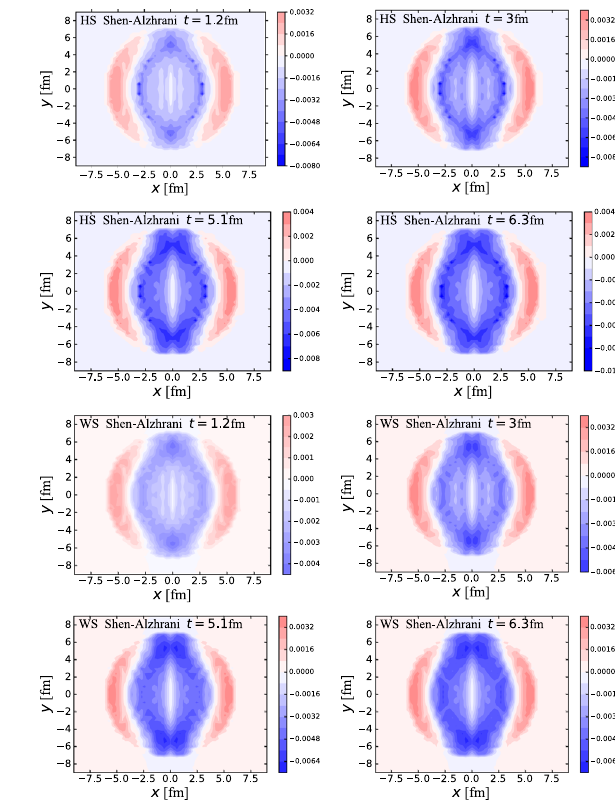
Fig. 9 Spatial distribution of quark polarization in the transverse plane at different times, compared between Hard Sphere (HS) and Woods– Saxon (WS) distributions of the initial nucleon density. The hydrody- namic evolution is initialized with the CCNU model